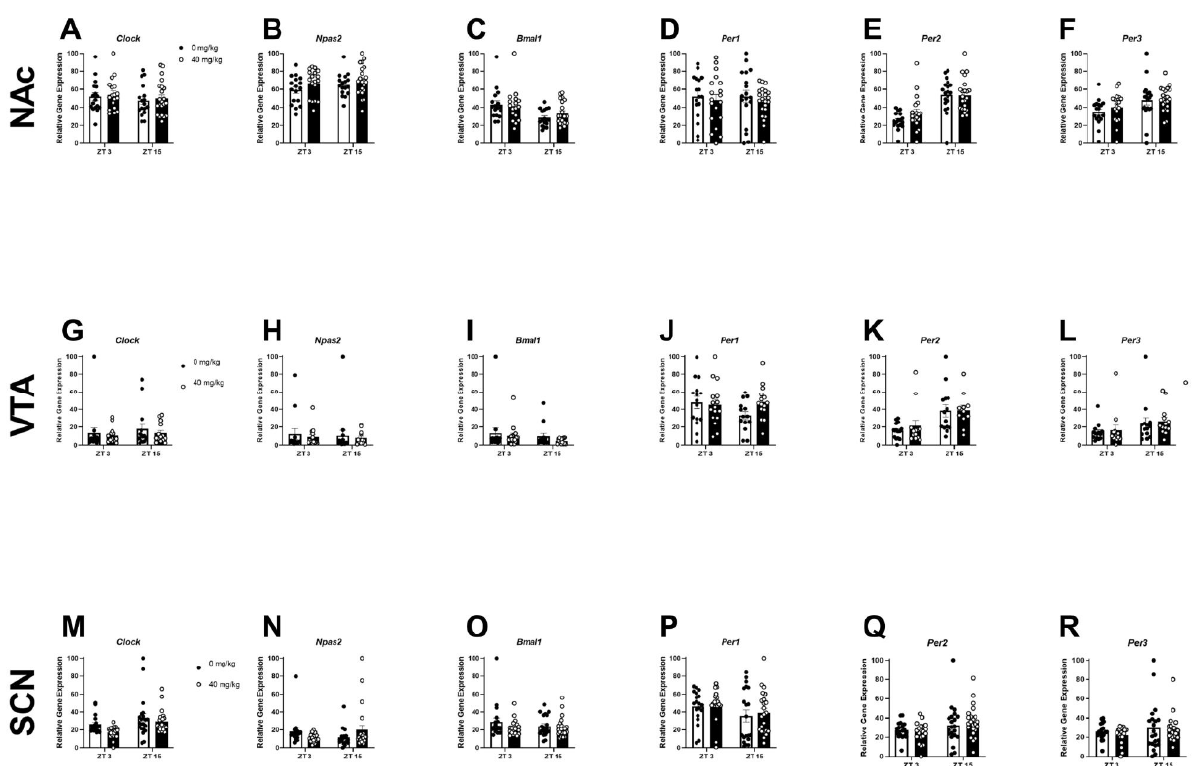
Figure 5. Apremilast treatment did not rescue the effects of chronic binge-like ethanol intake on circadian gene expression in male and female HDID-1 mice. The following core circadian genes— Clock , Npas2 , Bmal1 , Per1 , Per2 , Per3 —were analyzed across the NAc ( A – F ); VTA ( G – L ); and SCN